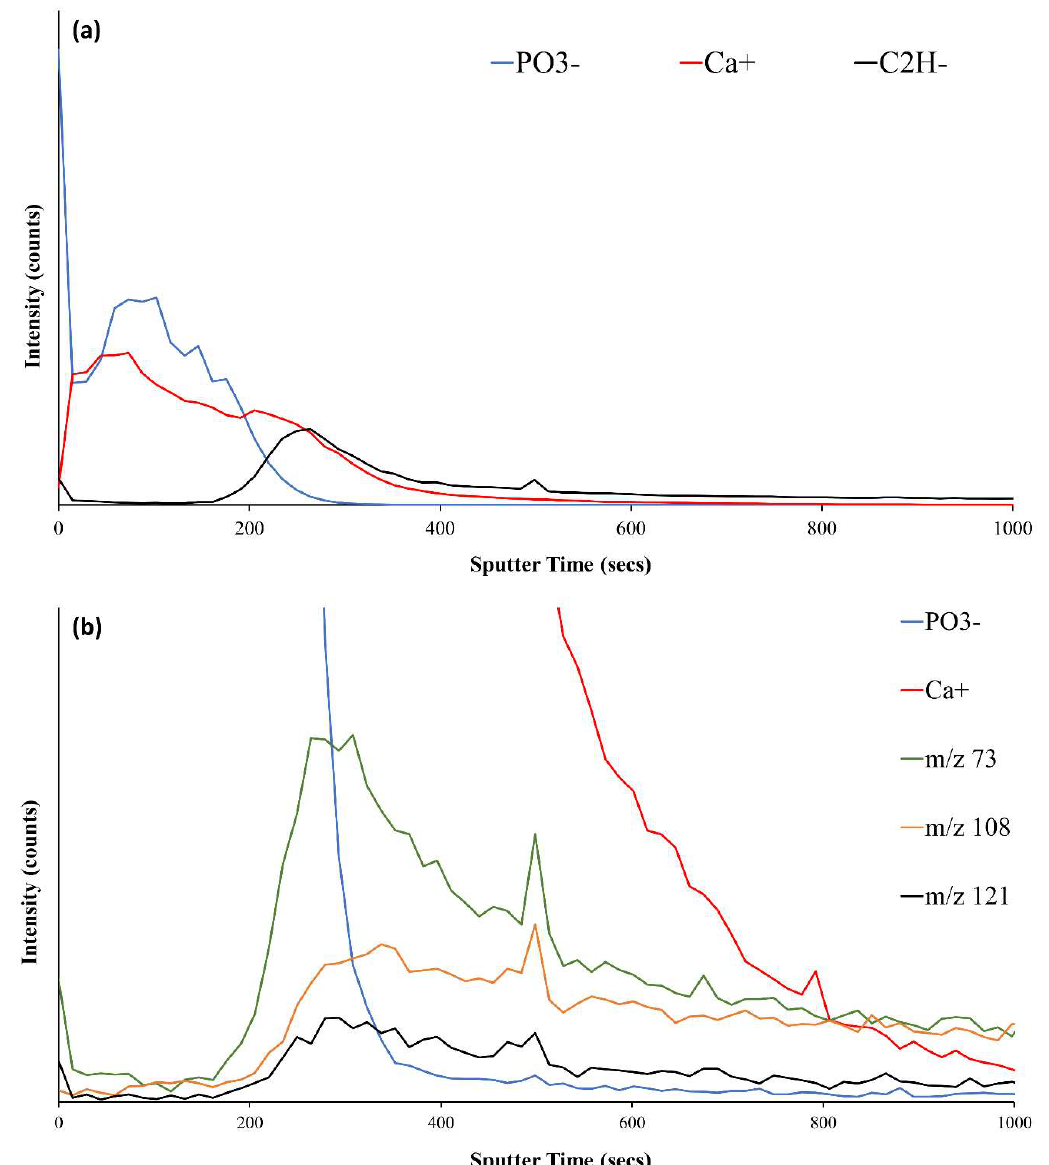
Figure 15. ToFSIMS depth profiles of CaP-modified PEEK (HA600). Positive and negative spectra are overlaid, {( a ) 100,000 counts, ( b ) 1000 counts.}.